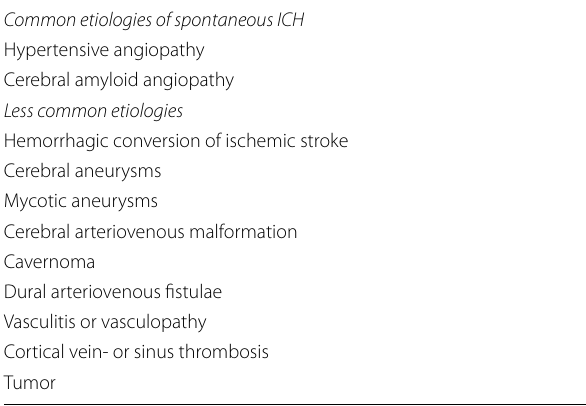
Table 1 The most common etiologies of spontaneous